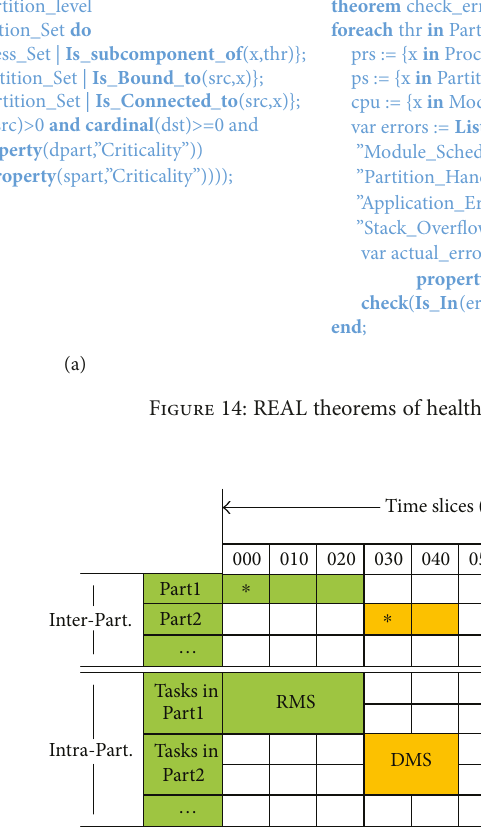
Figure 15: The scheduling model of IMA. ∗ means the start of